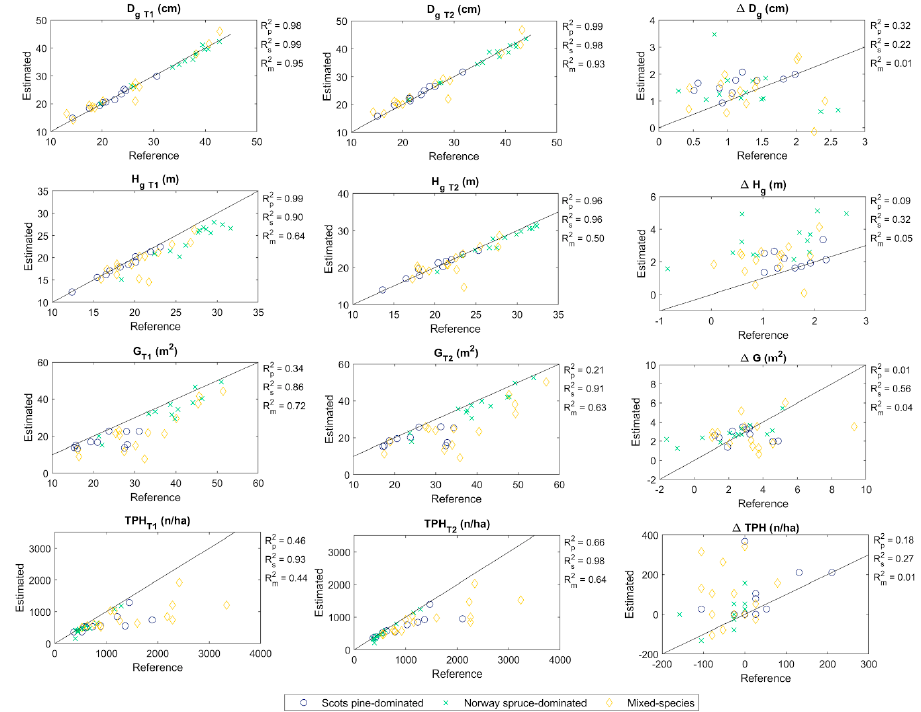
Figure 4. Relationship between the field-measured reference measurements and the TLS-derived estimates on forest structural attributes, such as basal area-weighted mean diameter (D g ) and -height (H g ), mean basal area (G), and number of trees per hectare (TPH) by main tree species in 2014 (T1) and 2019 (T2) as well as their difference ( Δ D g , Δ H g , Δ G, and Δ TPH). The solid black line represents the 1:1 relationship between the reference and the estimated values. R 2p , R 2s , and R 2b denote coefficient of determination for Scots pine-dominated, Norway spruce-dominated, and mixed-species forest plots, respectively.